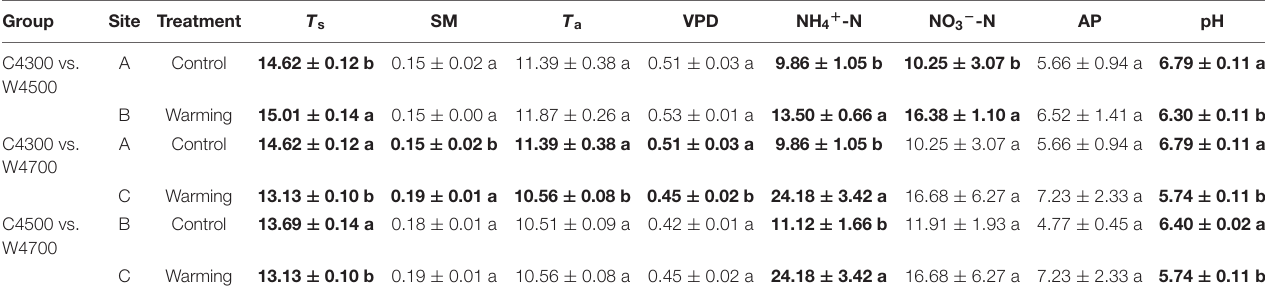
TABLE 1 | Comparison of average soil temperature ( T s ), soil moisture (SM), air temperature ( T a ) and vapor pressure deficit (VPD) across the nine growing seasons (i.e., 2011 – 2019), ammonium nitrogen (NH 4 + -N, mg kg − 1 ), nitrate nitrogen (NO 3 − -N, mg kg − 1 ), available phosphorus (AP, mg kg − 1 ) and pH across the six growing seasons (i.e., 2013 and 2015 – 2019) between the control treatment at site A (C4300) and the warming treatment at site B (W4500), between C4300 and the warming treatment at site C (W4700), and between the control treatment at site B (C4500) and the W4700 treatment, respectively. Group Site Treatment